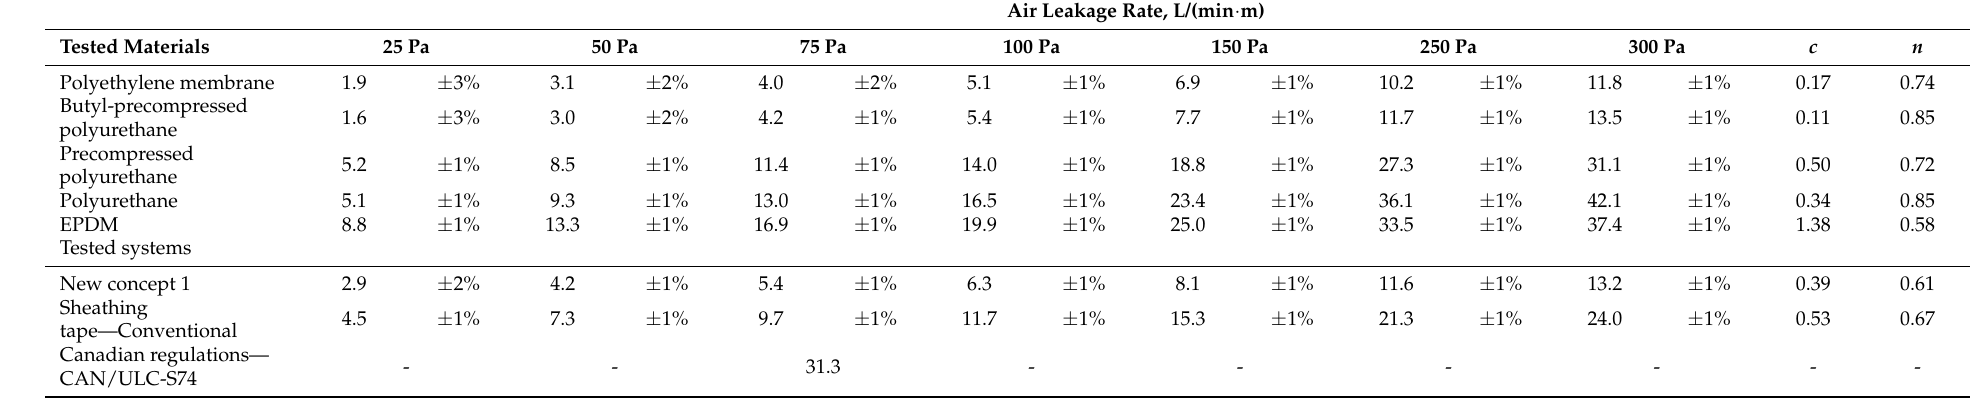
Table 3. Air leakage rate in horizontal junction between 2 walls tested in